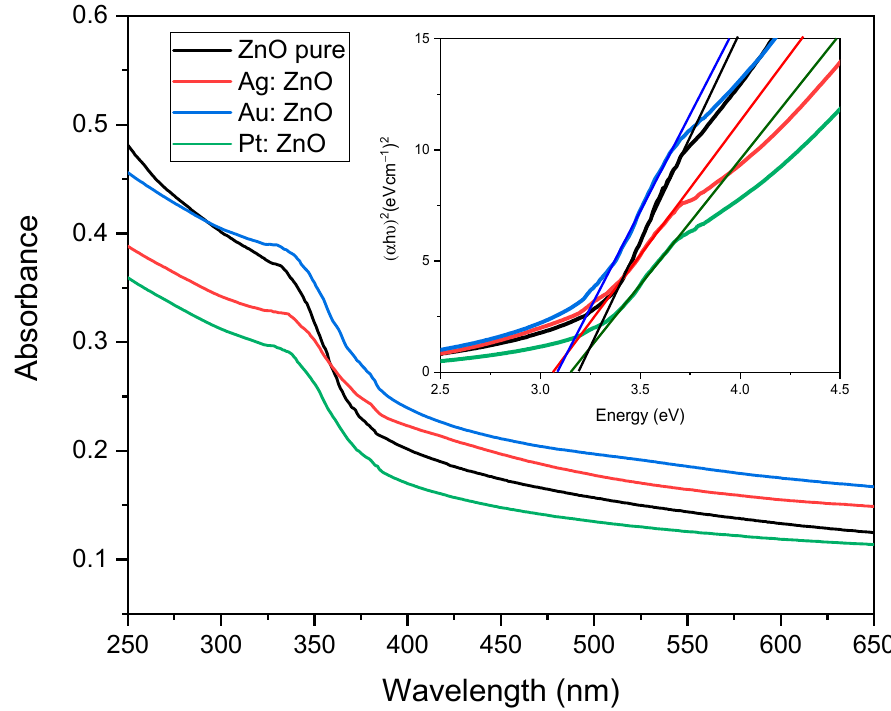
Figure 2. UV-Vis absorption spectra of the pure and Ag, Au, and Pt doped ZnO nanoparticles. The inset represents the Tauc plot of the same spectra showing the band-gap energies of 3.06 eV, 3.08 eV, 3.15 eV, and 3.20 eV for the Ag: ZnO, Au: ZnO, Pt: ZnO, and pure ZnO, respectively. Direct band-gap energies were obtained by extrapolating the linear part in a plot ( α h ν ) 2 versus E g = h ν (inset in Figure 2) following equation: (𝛼ℎ𝜈) (cid:2870) = 𝐴(cid:3435)ℎ𝜈 − 𝐸 (cid:3439) (1) (cid:3034) where α is the absorption coefficient, h is Planck’s constant, h ν is the photon energy, A is a constant, and E g is the optical band-gap. The estimated band-gap energies are 3.06 ± 0.02 eV, 3.08 ± 0.02 eV, 3.15 ± 0.03 eV, and 3.20 ± 0.04 eV for the Ag: ZnO, Au: ZnO, Pt: ZnO, and pure ZnO, respectively. There is a decrease in the band-gap energies in the case of the doped ZnO NPs showing changes in the nanocrystal electronic structure of the doped ZnO [46] and more efficient light absorption. The narrowest band-gap energy has Ag- doped ZnO NPs because of the highest atomic content inside ZnO. Also, our synthesized ZnO has lower band-gap energy compared to the literature value of 3.37 eV [27]. The photoluminescence (PL) spectra (Figure 3) obtained at room temperature offer an insight into the optical properties of the pure and doped ZnO NPs. Typical PL ZnO spectra consist of the peaks in the UV region related to the near-band-edge emission and the visible region attributed to the deep-level emissions. The peak at 3.26 eV (380 nm) for pure and doped ZnO is ascribed to the recombination of the electron and hole pairs (exci- ton recombination) aligning with the near-band edge of ZnO [47,48]. For doped ZnO NPs, the peak decreases compared to the pure ZnO, implying a decrease in the recombination rate of the electrons and holes. The emission peak at 3.12 eV (398 nm) can be attributed to the electronic transition from a lower energy excitonic state or to the Zn interstitial, which lies ~0.22 eV below the conduction band [49]. As it can be seen from the inset in Figure 3, the emission peak at 3.12 eV is well fitted with Zn i interstitial [50]. Pure ZnO displays a yellow emission with a maximum at ~2.11 eV (~588 nm), which is related to the exciton